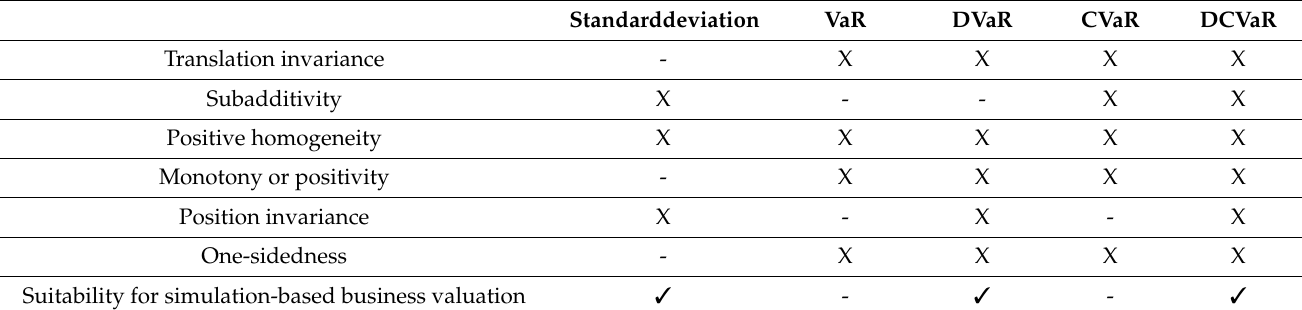
Table 5. Risk measures and their